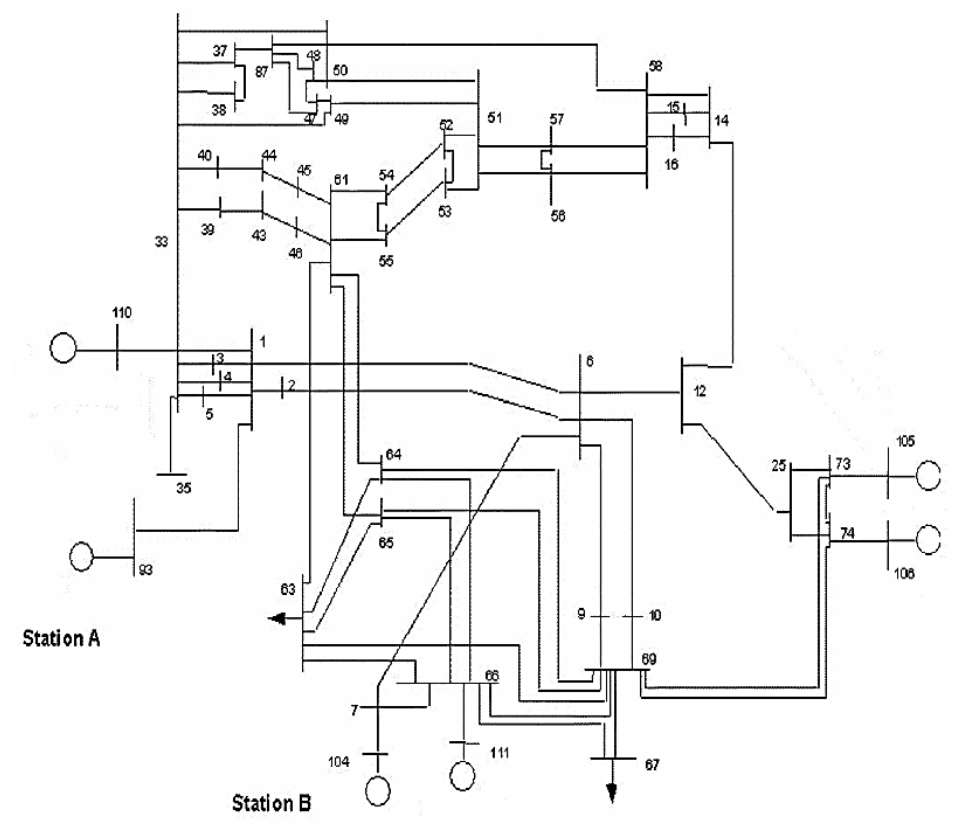
Figure 18. Two-area fifty-machine power system [68].